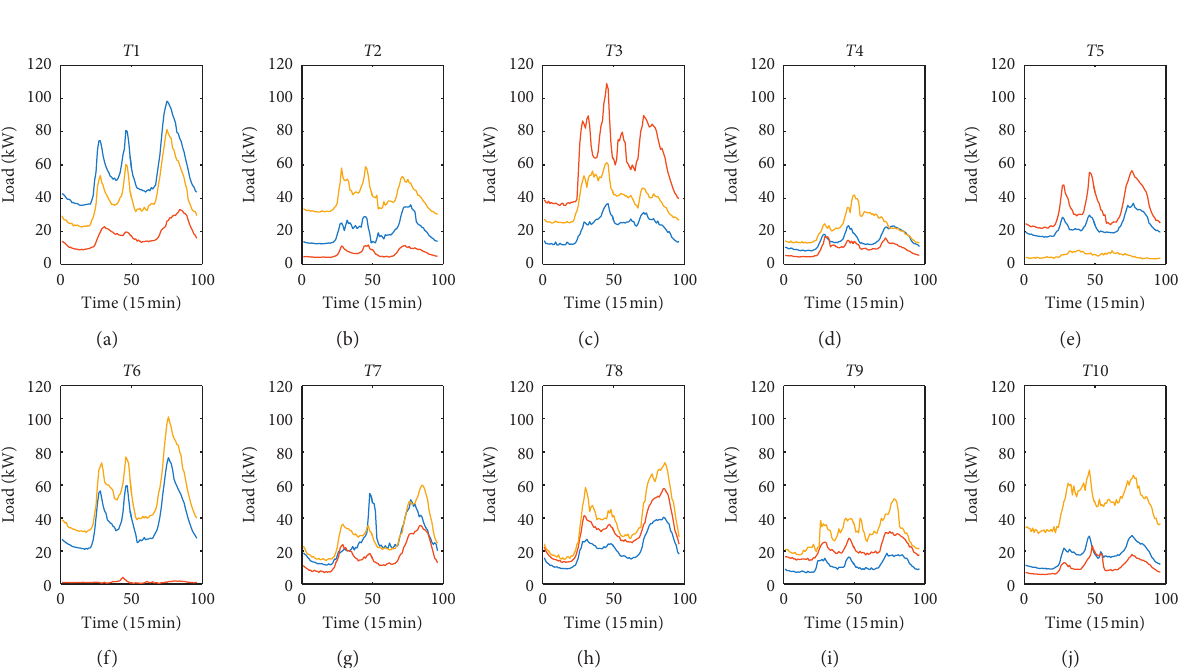
Figure 6: The center curves of the three clusters with the largest number of samples of part of distribution